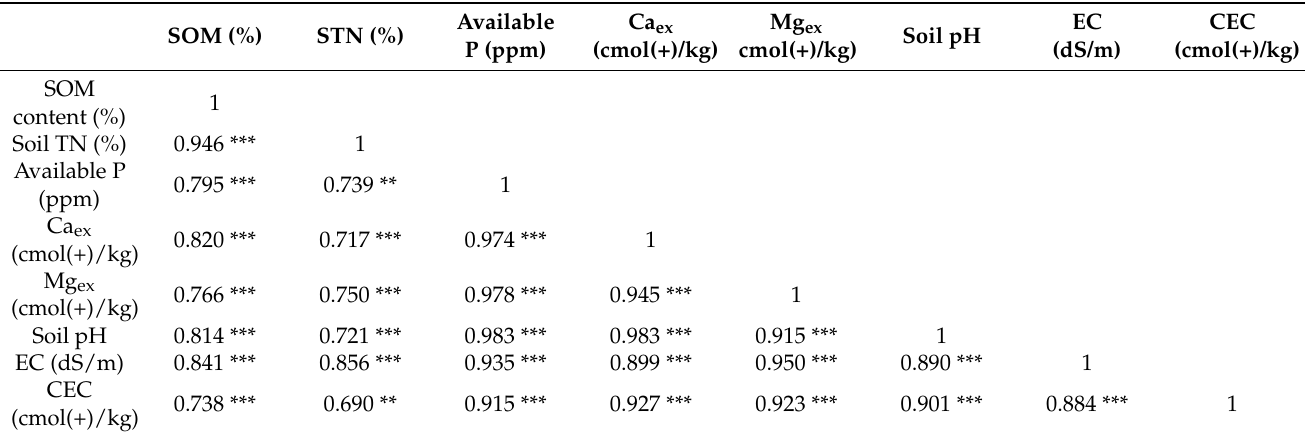
Table 6. Relationship among soil properties as influenced by lime and manure amendment; ( n = 27). SOM (%) STN (%)